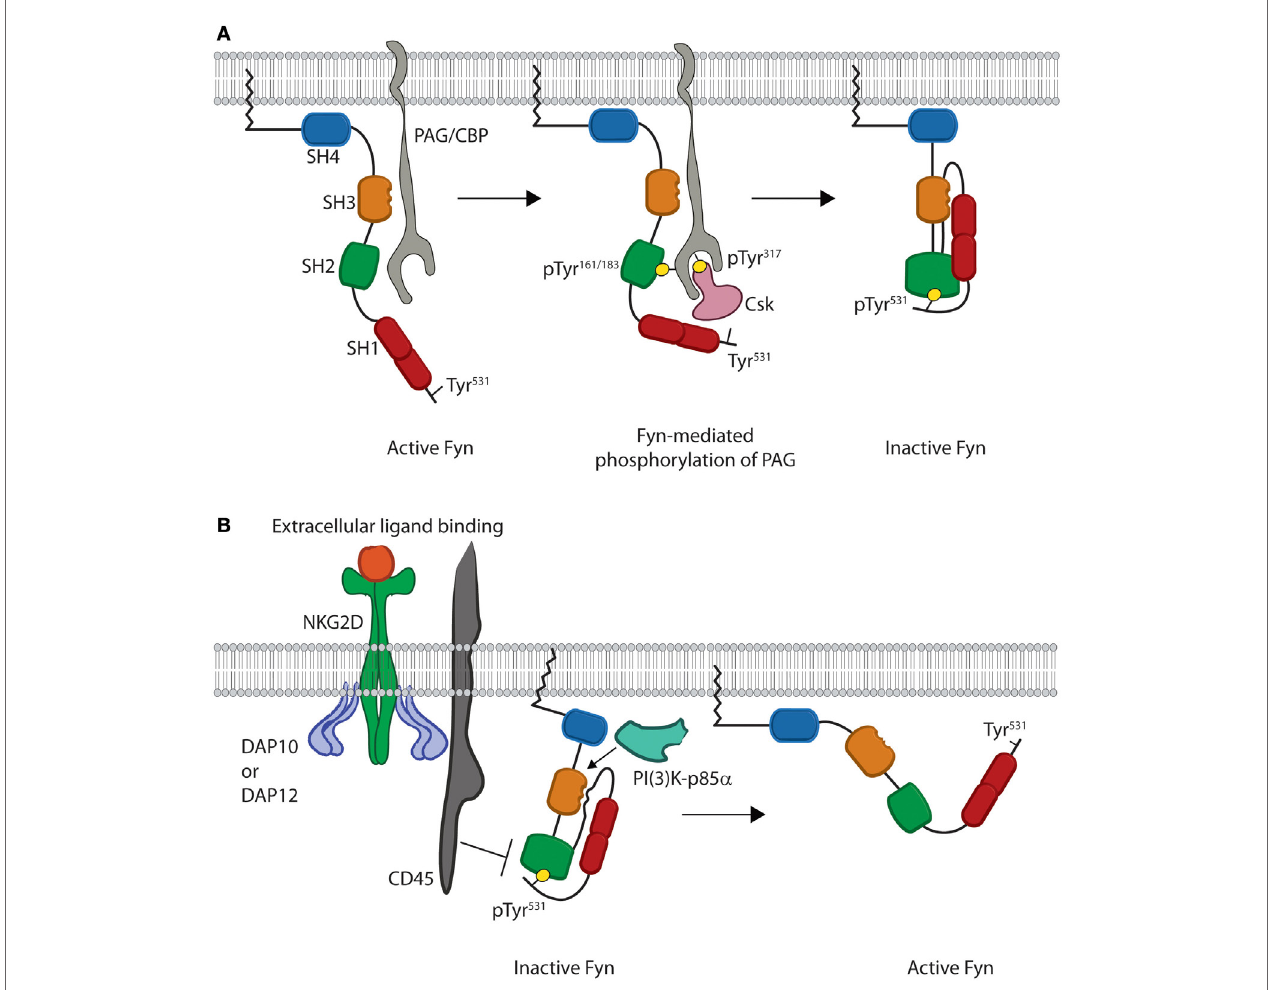
FiGURe 2 | Models for inhibition and activation of Fyn . (A) Fyn regulation is reliant on phosphorylation of an inhibitory tyrosine, Tyr 531 , in the C-terminal regulatory region. This is initiated by binding of the SH3 domain of open Fyn to PAG/CBP (gray) (left). This leads to subsequent phosphorylation of tyrosine residues on PAG/CBP, and these tyrosine residues bind the SH2 domains of both Fyn and Csk (pink) (center). Csk then phosphorylates the C-terminal inhibitory Tyr 531 , which leads to intramolecular binding of the Fyn SH2 domain and disrupts the interaction of Fyn with PAG/CBP. Fyn is then released from PAG/CBP and remains anchored in the membrane as an inactive kinase molecule (right). (B) Fyn is locked in the inactive conformation until cellular activation leads to disruption of intramolecular binding. Stimulation through NKG2D leads to activation of the CD45 phosphatase (left). CD45 then removes the phosphate from the C-terminal inhibitory tyrosine and disrupts the intramolecular interactions responsible for keeping Fyn in a closed conformation. These interactions are also disrupted upon binding of substrates, such as PI(3)K-p85 α , to the Fyn SH3 domain. This prevents the SH3 domain from binding to the linker region. Loss of these intramolecular interactions causes Fyn to adopt a more open conformation where the SH2 and SH3 domains are able to mediate substrate recruitment, while the kinase domain mediates enzymatic activity